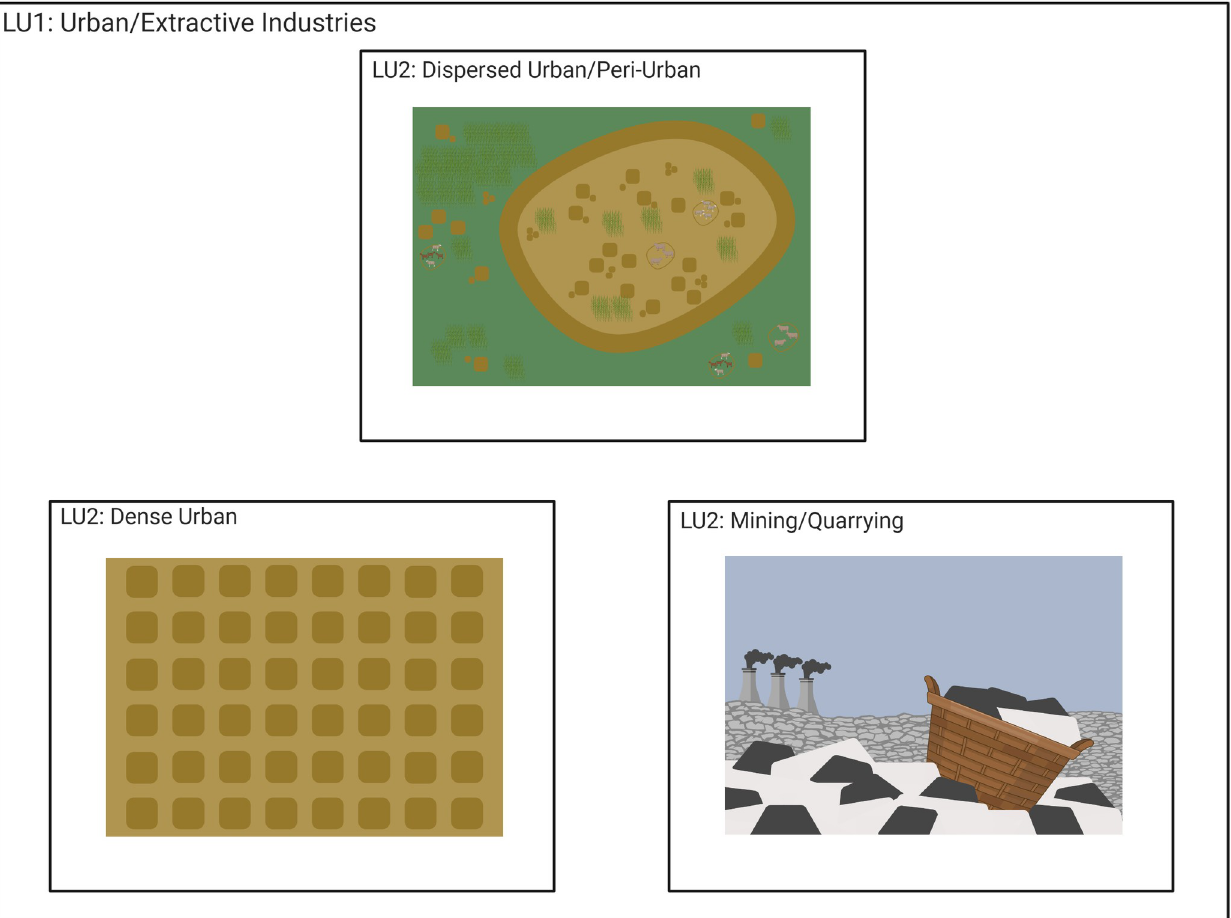
Fig 7. LU1-“Urban/Extractive industries” shown as several LU2 categories: LU2-“dispersed urban/peri-urban” shows a spread-out settlement with houses beyond the wall/edge of the settlement, and agriculture space within the settlement limits. LU2-“dense urban” shows closely packed houses/ buildings with little green/agricultural spaces. LU2-“mining/quarrying” is represented by a stone mine. Created with BioRender.com, under a CC BY license, with permission from Biorender, original copyright 2020.